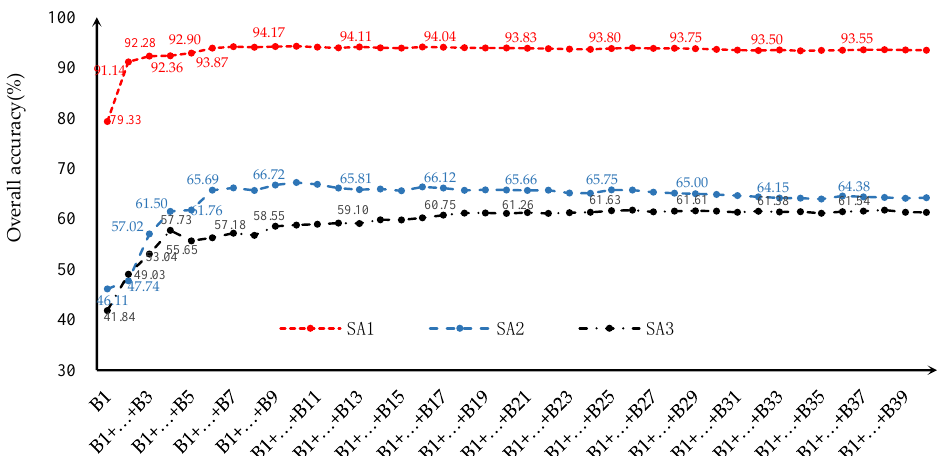
Figure A3. Relationship between accumulated textural features and overall accuracy.